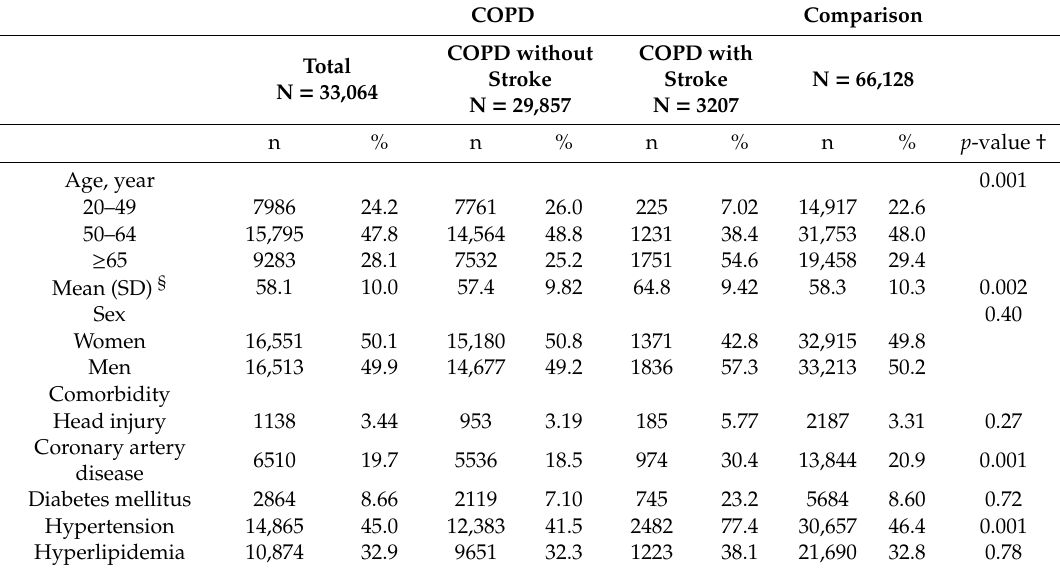
Table 1. Distributions of age, sex, and comorbidity in the chronic obstructive pulmonary disease (COPD) and comparison subgroups.